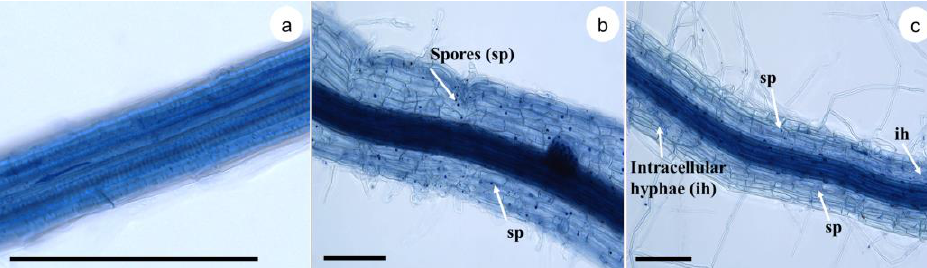
Figure 3. Colonization of sugarcane plantlets ( Saccharum spp. cv Mex 69-290) with Glomus intraradices 60 d after spore inoculation. Fungal structures, such as spores (sp) and intracellular hyphae (ih), were observed by bright-field microscopy. ( a ) Control treatment, ( b ) 100 spores per plantlet, and ( c ) 200 spores per plantlet. Black Bar = 150 µ m.